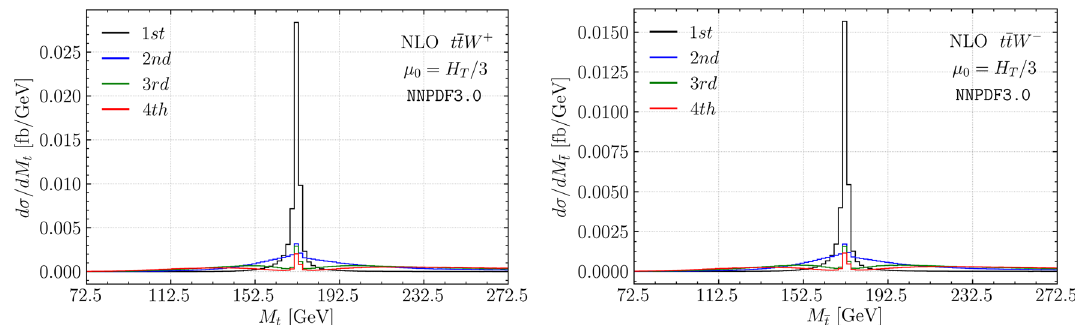
Fig. 3 Reconstructed invariant mass of the top quark and anti-top quark at NLO in QCD for pp → t ¯ tW + and pp → t ¯ tW − in the multi-lepton √ s = 13 TeV. The NLO NNPDF3.0 PDF set is employed and μ R = μ F = μ 0 where μ 0 = H T / final state. Results are given for the LHC with